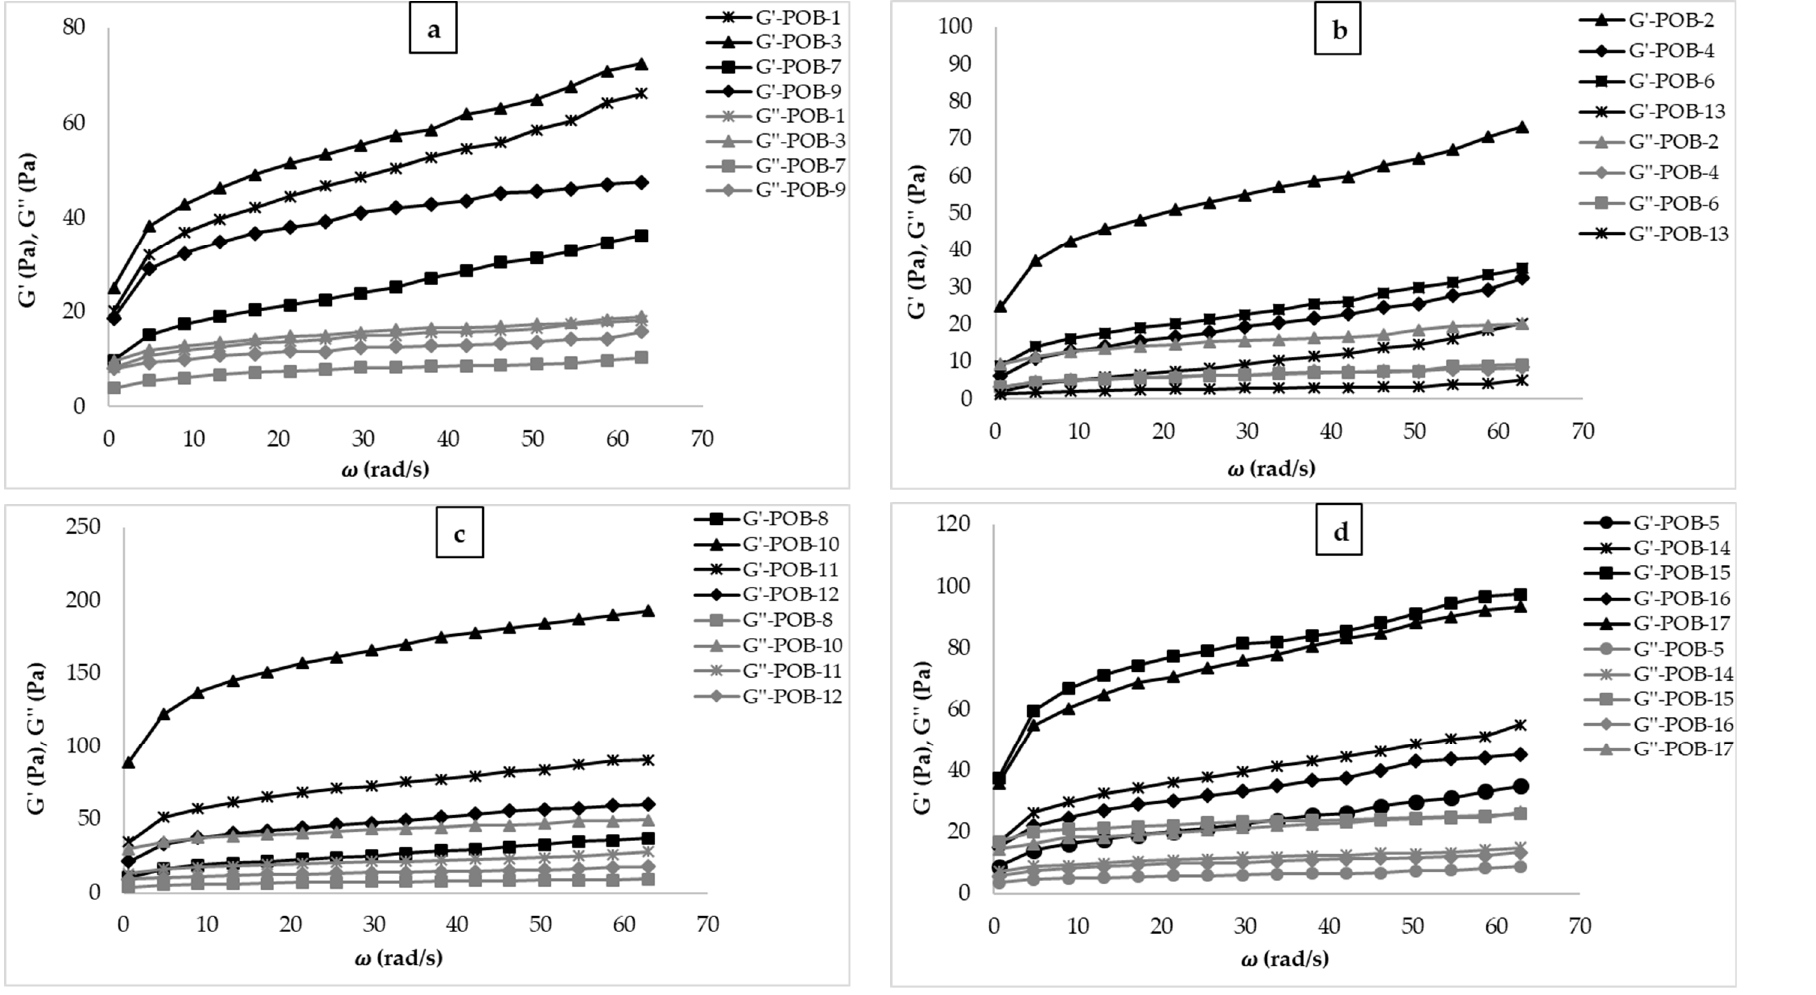
Figure 2. G ׳ and G ″ values versus angular velocity values of salad dressing samples (POB: cold-pressed pumpkin seed oil by-product, G ′ (Pa): storage modulus, G ″ (Pa): loss modulus). ( a ): G ′ and G ″ of POB-1, 3, 7, & 9; ( b ): G ′ and G ″ of POB-2, 4, 6, & 13; ( c ): G ′ and G ″ of POB-8, 10, 11, & 12; ( d ): G ′ and G ″ of POB-5, 14, 16, & 17.